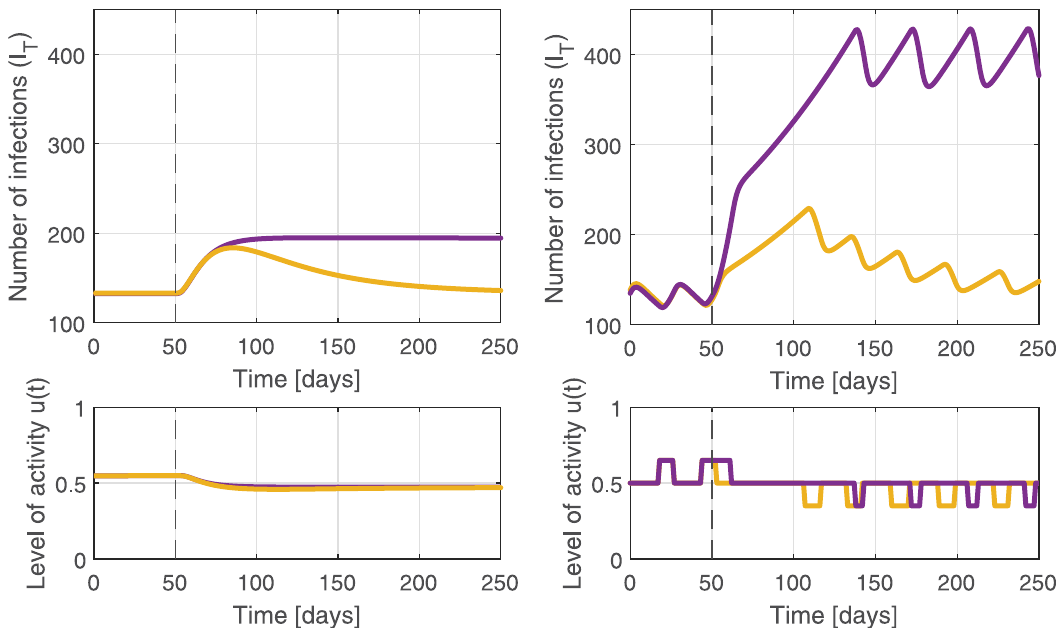
Fig 7. Feedback mitigates the effect of waning compliance to health directives. Left: After 50 days, the effectiveness of interventions decreases. Feedback control increases the level of interventions accordingly to stop pandemic growth. To fully counteract the (input) uncertainty, the cumulative error needs to be taken into account in the policy update (yellow; i.e., through the integrator term K i ). If not (purple), the pandemic is stabilized at a sustained higher level of infections. Right: This effect is amplified if only a limited number of intervention levels are available. The area under the curve not using the cumulative error (purple) is 85% higher than when the cumulative error is used